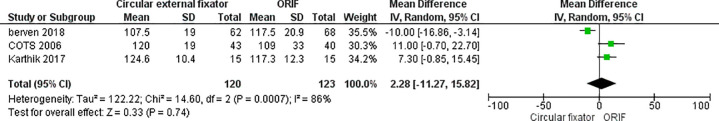
Forest plot for range of motion between ORIF and circular external fixator.